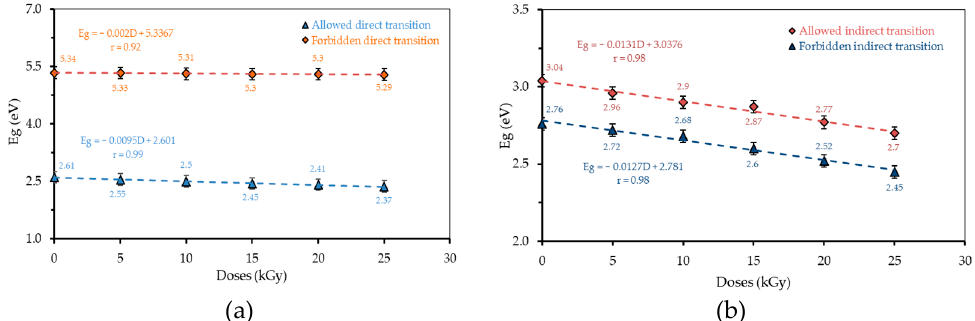
Figure 7. The relationship between the radiation dose and Eg for each transition of H 3 PO 4 85 v%: ( a ) direct transition; and ( b ) indirect transition.